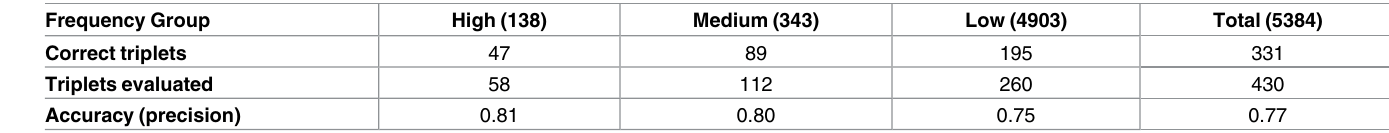
Table 2. Precision computation based on human annotation of random samples from uncurated mutations. Frequency Group Triplets evaluated Accuracy